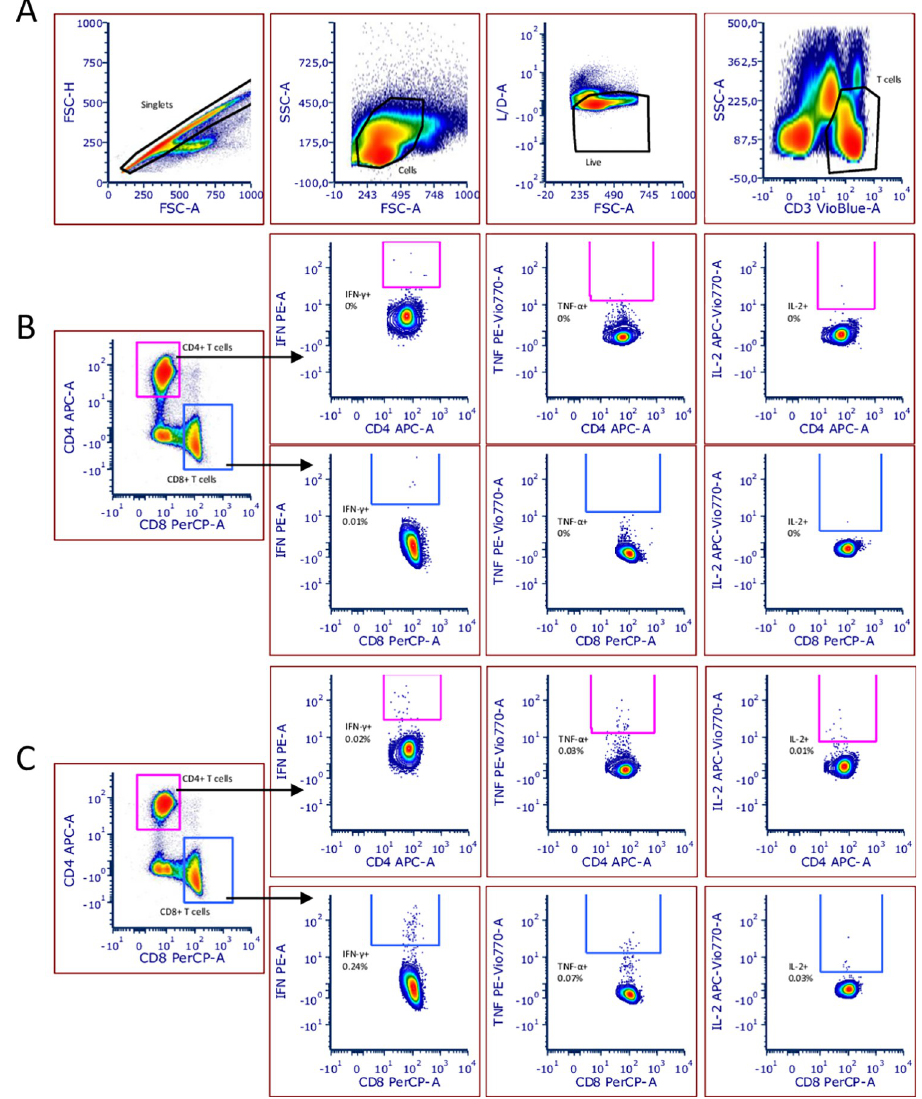
Fig 8. Gating strategy of the intracellular cytokine staining. The figure shows a representative flow cytometry gating strategy for one of the donors. Cells were gated as follows: Singlets, Cells, Live, CD3+ T cells (A) and further T cells were divided into CD4+ and CD8+ T cells and from each of the subsets IFN- γ +, TNF- α +, or IL-2+ cells were gated (B, C). Panel B shows the negative control and Panel C shows the restimulated condition with the Miltenyi peptide mix of the same representative